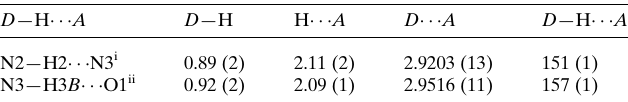
Table 1 Hydrogen-bond geometry (A˚ , (cid:4) ).